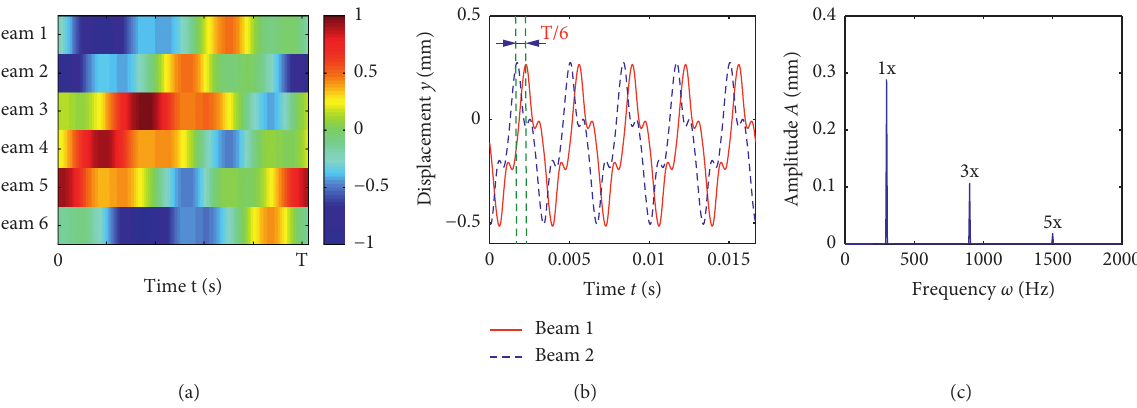
Figure 16: The response of beam root with respect to case 2 ( Ω � 200rad/s, F � 300N, ω � 300Hz): (a) response of beam 1 to beam 6, (b) response curve of beams 1 and 2, and (c) spectrum plot of beam